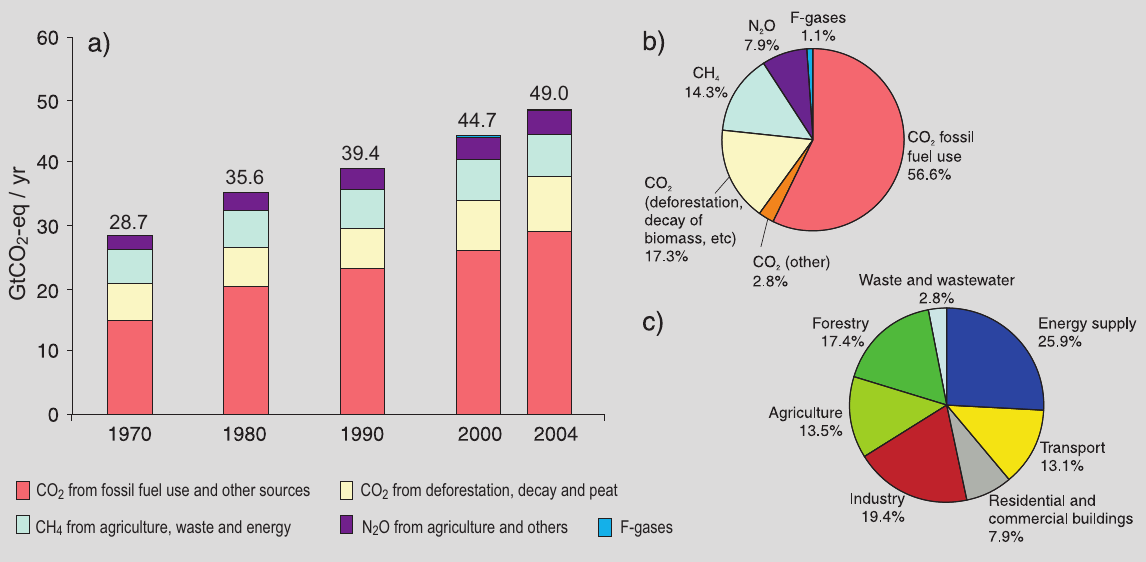
Figure SPM.3. (a) Global annual emissions of anthropogenic GHGs from 1970 to 2004. 5 (b) Share of different anthropogenic GHGs in total emissions in 2004 in terms of carbon dioxide equivalents (CO -eq). (c) Share of different sectors in total anthropogenic GHG emissions in 2004 2 in terms of CO -eq. (Forestry includes deforestation.) {Figure 2